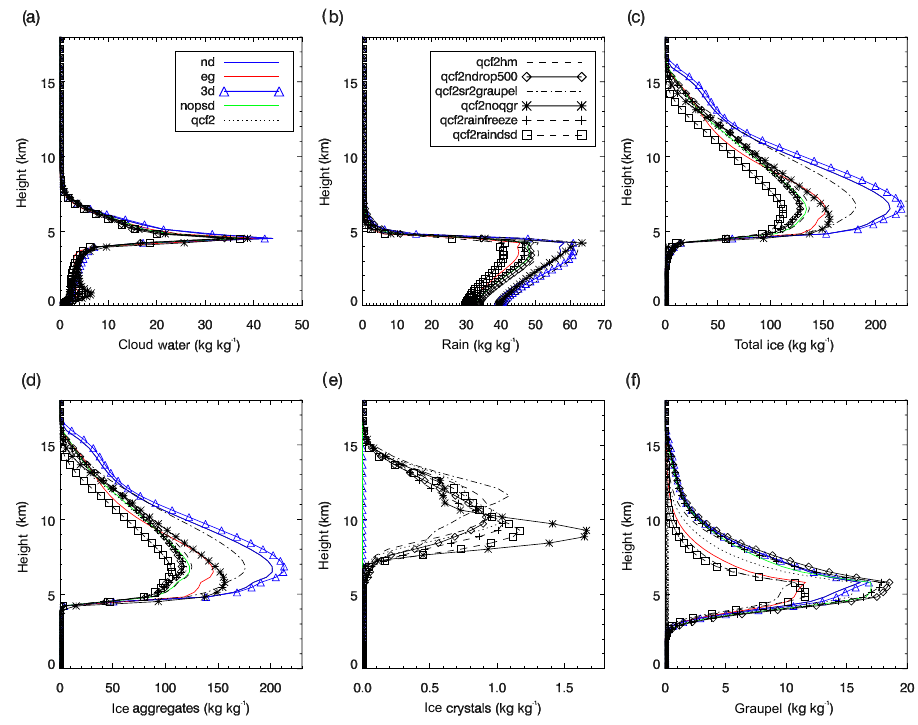
Figure 13. For the aircraft analysis region (150km radius from the mean aircraft track), the total accumulated water contents (kgkg − 1 ) over the domain from 23:00 to 24:00UTC. (a) Cloud liquid water, (b) rain water, (c) total ice, (d) ice aggregates/snow, (e) ice crystals and (f)